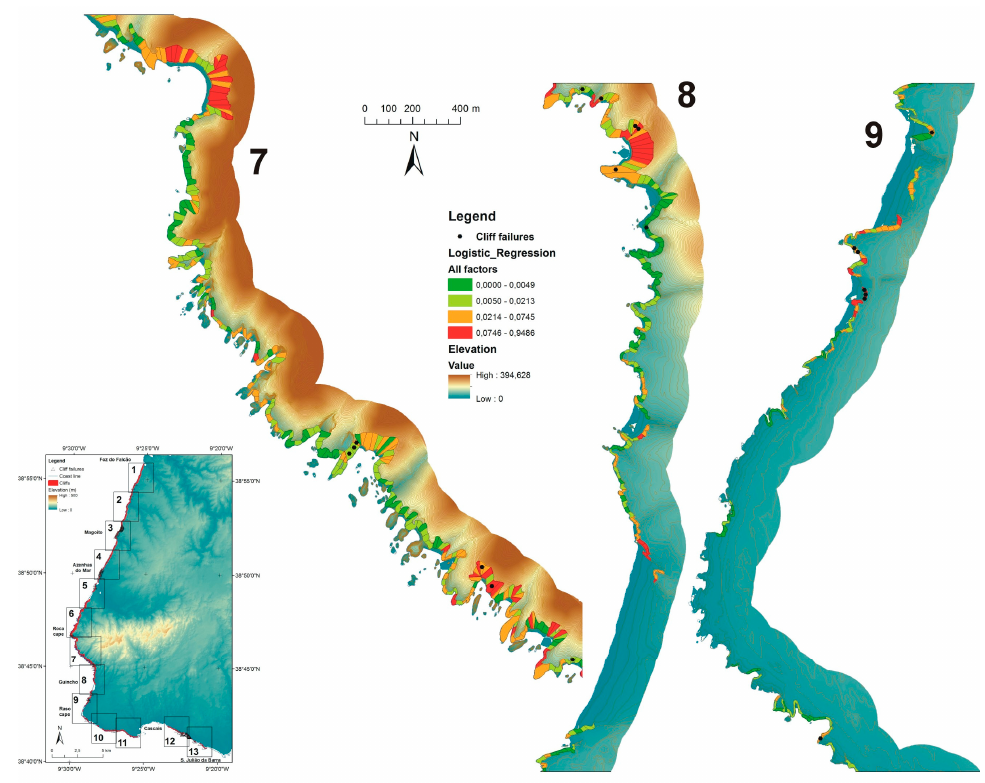
Figure 8. Susceptibility mapping (3/4) for cliff sections 7 to 9 (legend as Figure 7).